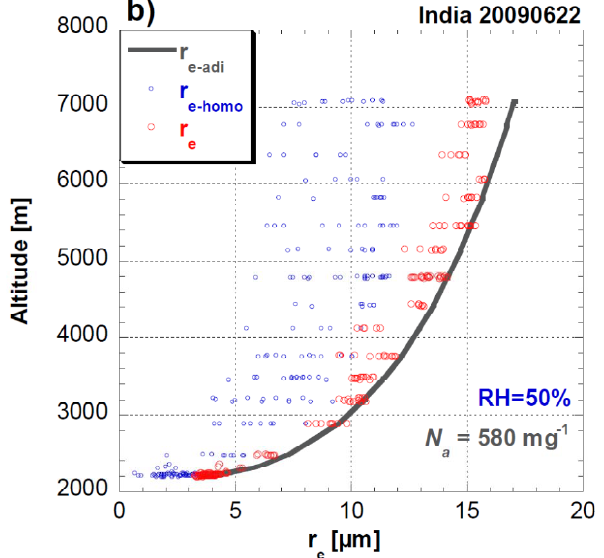
Fig. 2. Aircraft observations of tight relationships between r e and altitude in a cluster of deep convective clouds over India. Each red circle marks the r e measured in a 1-s ( ∼ 100m) flight path. The dark curve shows the profile of the adiabatic r e ( r ea ). The figure is taken from Freud et al. (2011), The N a is calculated by the method- ology described in Freud et al. (2011). It can be seen that for any given cloud depth the scatter of r e is fairly small, and that values are normally within 2µm from r ea , despite including measurements with down to 5% of adiabatic water. The blue circles indicate the expected effective radii in case of fully homogeneous mixing with entrained air which has 50% relative humidity (RH), which was ob- tained from a nearby sounding. They are calculated for the mixing proportions of the actually measured adiabatic fractions. Similar re- lations are shown elsewhere in the world by Rosenfeld and Freud (2012).